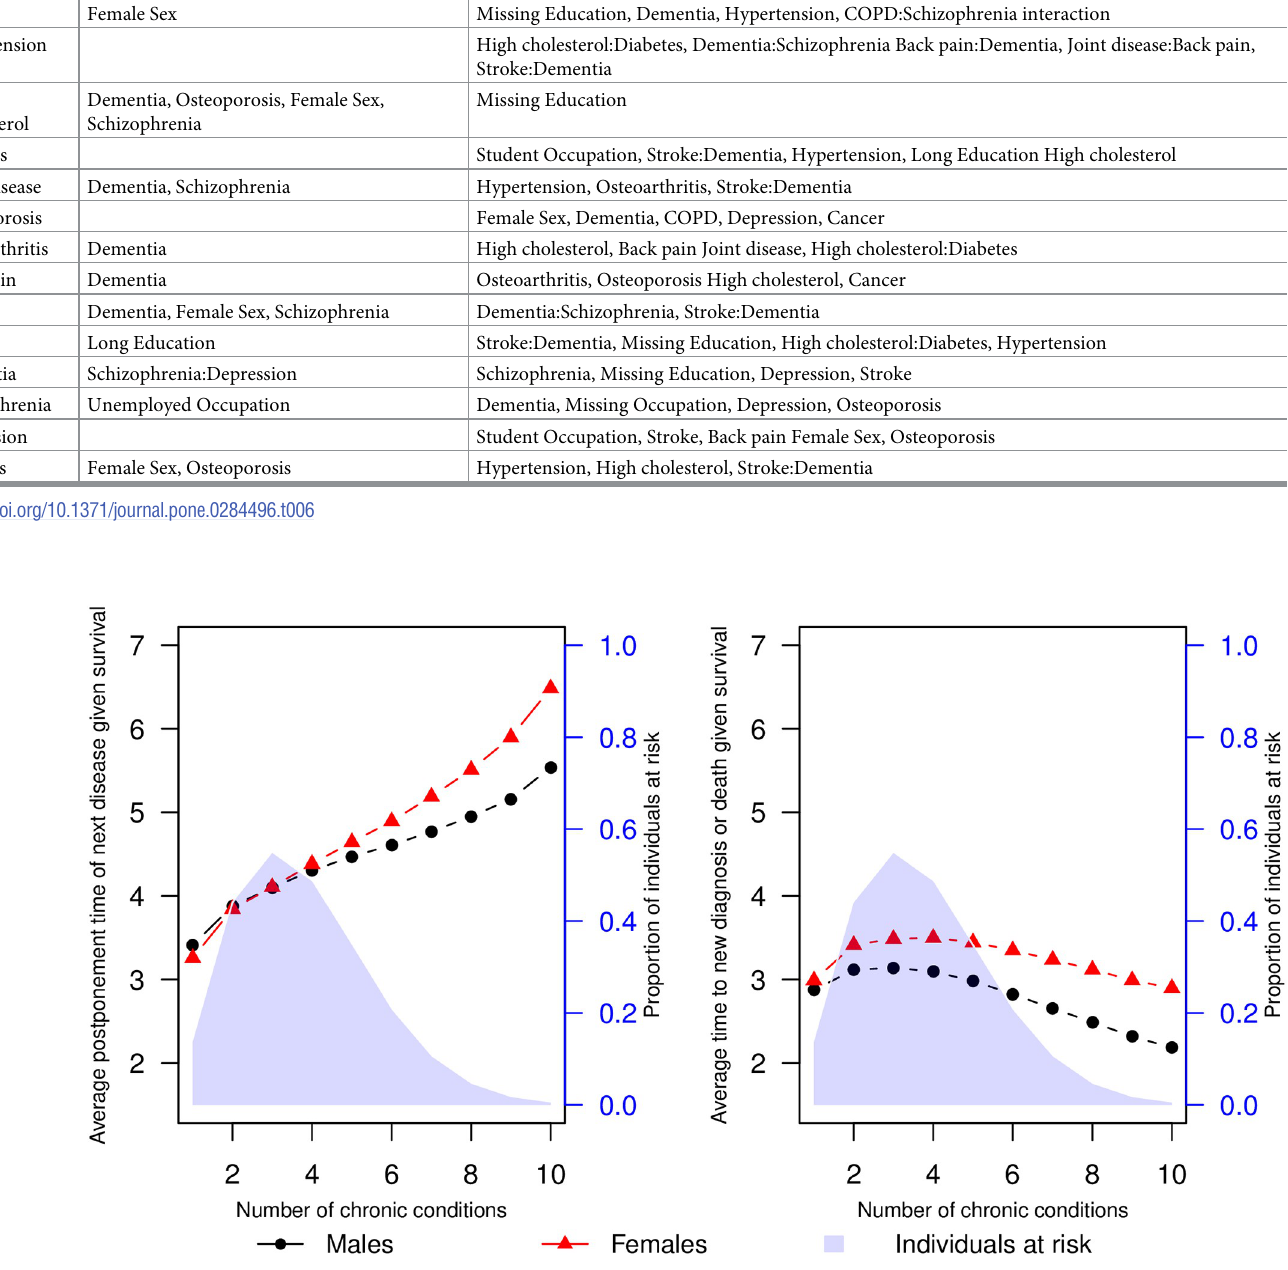
Fig 4. Effect of multimorbidity on postponement times. Estimated mean postponement time of next chronic diagnosis given survival for retired males and females of no education at a set multimorbidity level (left). The mean postponement times are estimated as an average of estimated postponement times for all possible combinations of chronic conditions given the multimorbidity level, weighted by the observed frequency of these combinations. The blue shaded area represents the proportion of HD individuals at risk of a new event. For reference, the right plot represents the same estimates in a model where the new disease event and death are considered a combined